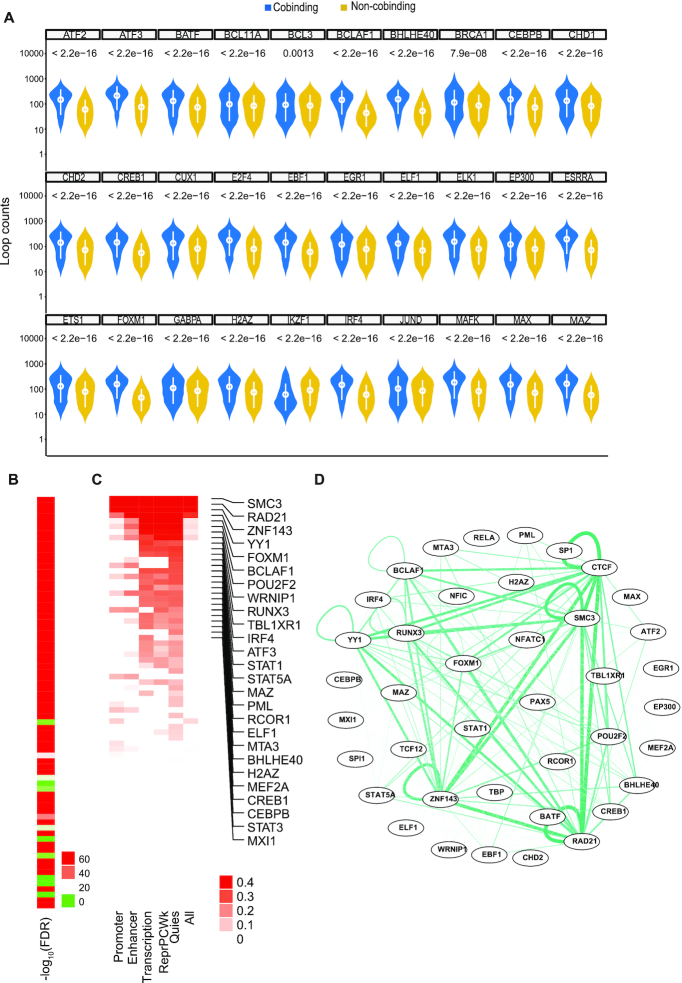
Individual factor analysis reveals potential loop-correlated factors. (A) Examples of CTCF loop strength distribution between factor cobinding and non-cobinding regions for each protein factor in GM12878 cells. Factors were shown alphabetically. Y axis is log10 scaled. (B) Heatmap showing –log10(FDR) of CTCF loop strength between factor cobinding sites and factor non-cobinding sites for each protein factor. (C) Heatmap showing the correlation between normalized factor binding strength and log2 transformed CTCF loop strength. Factors were listed by maximum correlation, and the factor with maximum correlation >0.2 was selected. (D) Network visualization displaying the frequency of factor pair appearance in paired loop anchors. FDR value in (A) and (B) was calculated using Wilcoxon rank sum test and adjusted for multiple comparisons using Bonferroni correction.